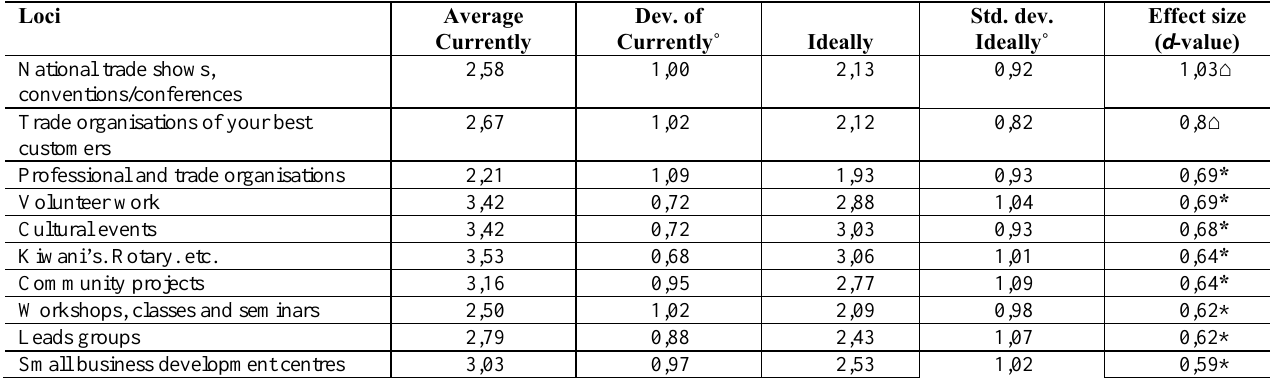
Dev. of Currently Currently ˚ Ideally